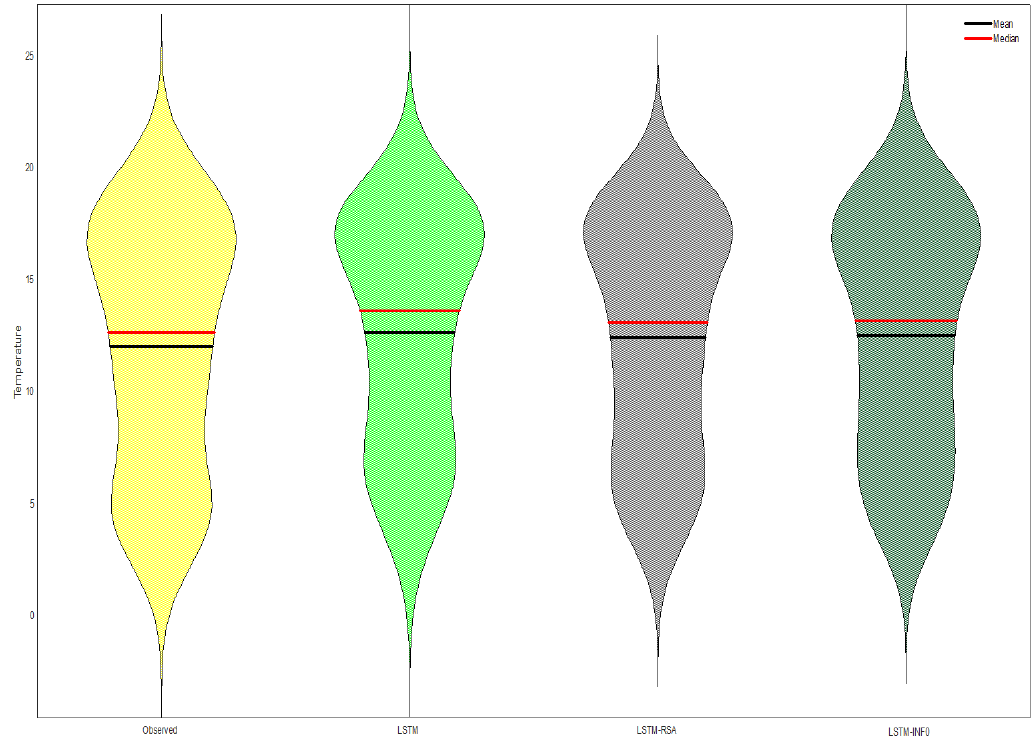
Figure 10. Violin charts of the predicted water temperature using different CNN-based models in the test period with the best input combination.